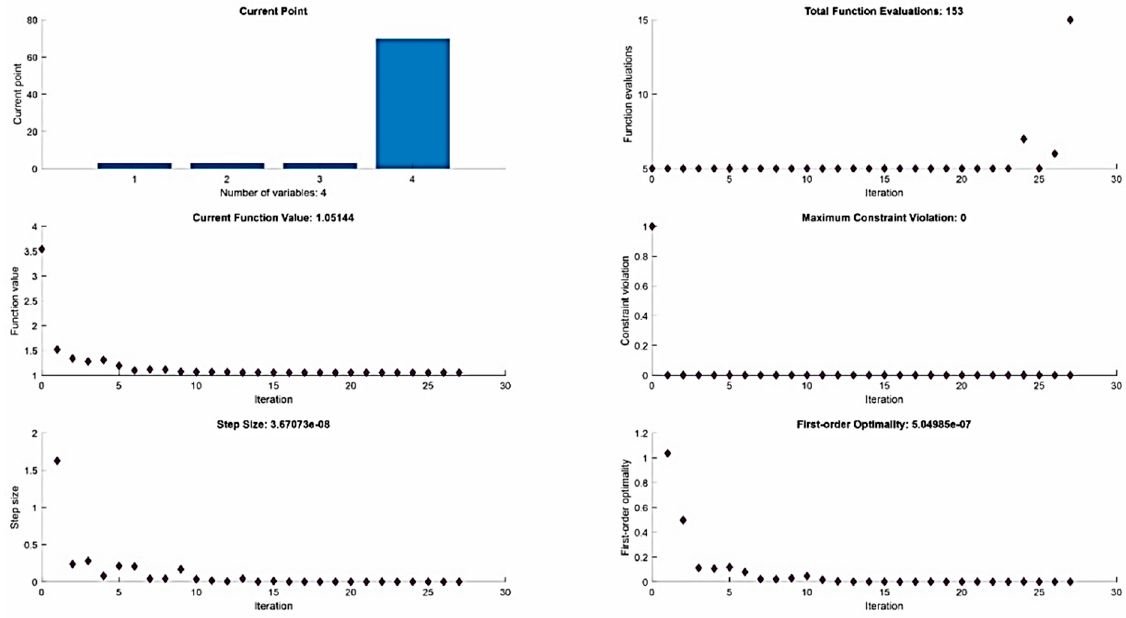
Figure 7. Graphical representation of the outputs of the performed optimization of the quality parameter of the machined surface after µ-WEDM of maraging steel MS1.